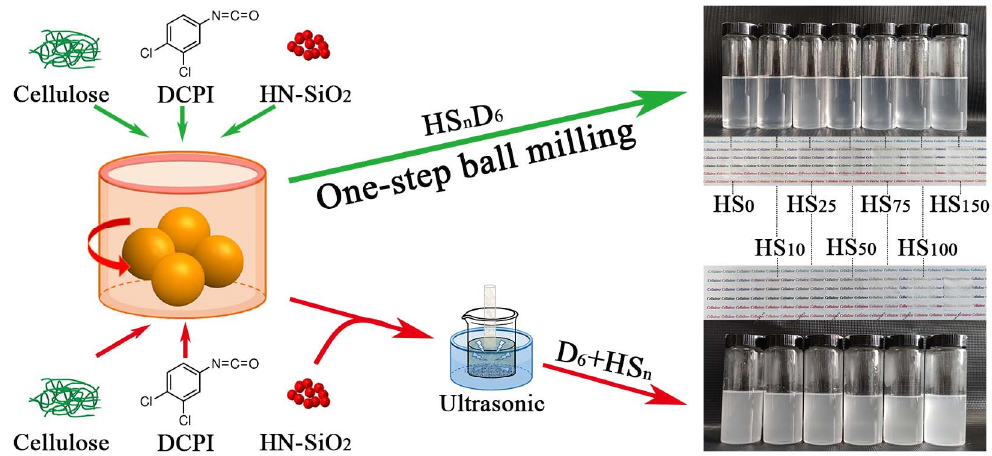
Figure 1. Schematic of the preparation of hydrophobic CNF/HN-SiO 2 composite by ball milling.